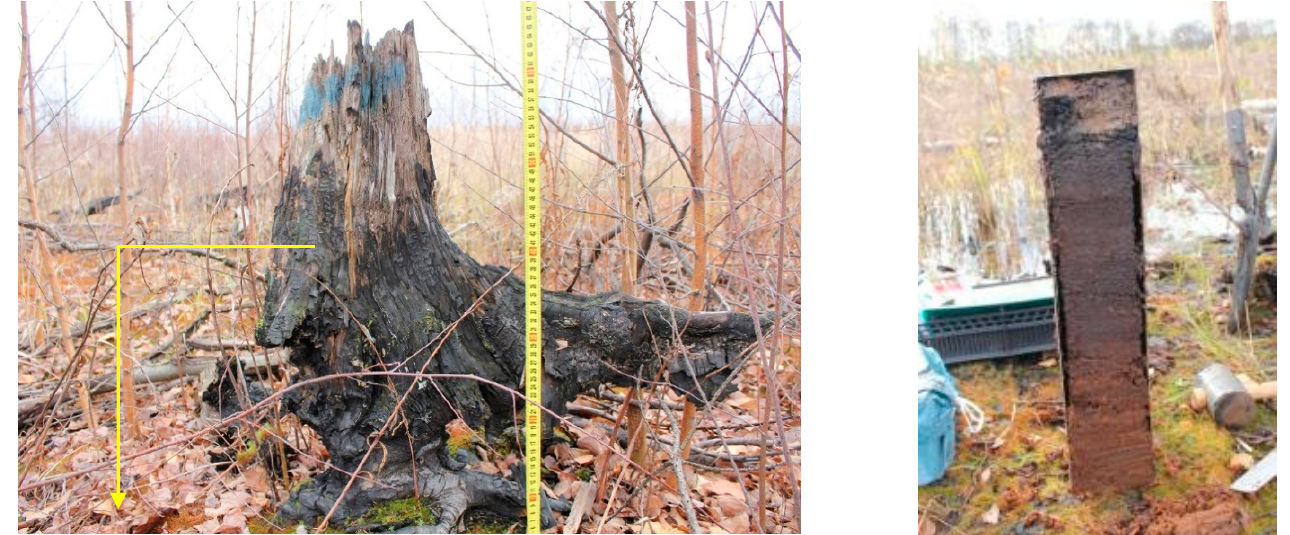
Figure 3. Reconstruction of the pre-fire surface level using the root collar of trees ( left ) and peat cores to assess peat bulk density and other soil variables ( right ).